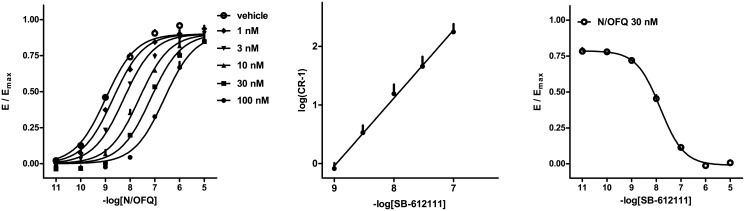
NOP receptor / G protein interaction experiments—concentration-response curves to N/OFQ in absence and in presence of increasing concentrations (1–100 nM) of SB-612111 (left panel).The corresponding Schild plot is shown in the middle panel. The inhibition response curve to SB-612111 vs. N/OFQ 30 nM is shown in the right panel. Data are mean ± sem of 4 separate experiments performed in duplicate.